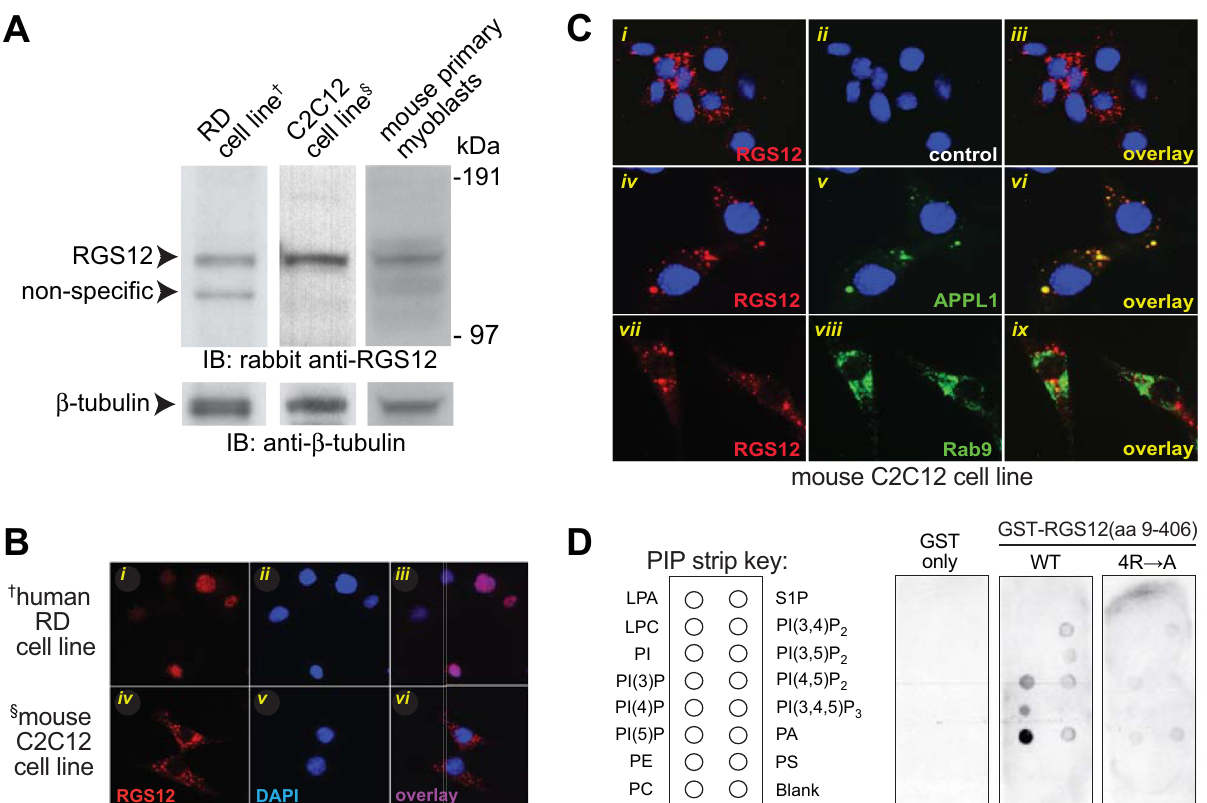
Fig 2. RGS12 expression is observed in cytosolic puncta within the myoblastic C2C12 cell line, but localized in the nucleus in the poorly differentiating human RD cell line. (A) Immunoblotting (IB) of cell lysates from all three cell types indicates RGS12 protein expression, as detected using a rabbit anti-RGS12 polyclonal antibody previously described [7]; β -tubulin protein levels were also examined by immunoblotting in parallel as a loading control. (B) Cultures of the poorly differentiating, human rhabdomysarcoma RD cell line and the more-easily differentiated, mouse C2C12 cell line were separately fixed and stained with DAPI; RGS12 protein was detected by indirect immunofluorescence using UNC60-26.2.1. Panels (i-vi) represent: (i, iv) anti-RGS12 antibody detection with Alexa-fluor-594 secondary antibody; (ii, v) DAPI nuclear stain; and, (iii, vi) overlay of both images. (C) Endogenous RGS12 localizes to early (APPL1-positive) endosomes within C2C12 cells. C2C12 cell line cultures (4 x 10 5 cells/well) were maintained in growth medium (DMEM containing 10% fetal bovine serum [FBS]) for two days. Cells were then fixed in paraformaldehyde, permeabilized, and stained with primary mouse monoclonal antibody UNC60-26.2.1 and secondary Alexa-fluor-594 anti-mouse antibody, alone or in combination with primary anti-APPL1 or -Rab9 rabbit polyclonal antibodies followed by Alexa-fluor-488 secondary anti-rabbit antibody. Overlays in panels (vii-ix) are absent the DAPI nuclear stain ( blue ) to highlight lack of overlap between RGS12 and Rab9 signals. (D) RGS12 N-terminus binds to select phosphatidylinositides in a lipid dot-blot protein overlay assay. A “PIP Strip” nitrocellulose membrane pre-spotted with the indicated phospholipid species was probed with 20 μ g/mL of GST alone, recombinant GST-RGS12 protein (amino-acids 9–406 spanning PDZ and PTB domains; “WT”), or GST-RGS12(aa 9–406) protein with alanine substitutions to four arginines in the PTB domain (Arg-255, -260, -262, and -308; “4R ! A”) previously predicted by electrostatic contouring [61] to be involved in phospholipid binding. After extensive washing, the binding of protein to phospholipid spots was detected by chemiluminescence using anti-GST mouse monoclonal antibody and anti-mouse-horseradish peroxidase conjugated secondary antibody. Lipid abbreviations: LPA, lysophosphatidic acid; LPC, lysophosphocholine; PI, phosphatidylinositol; PE, phosphatidylethanolamine; PC, phosphatidylcholine; S1P, sphingosine-1-phosphate; PA, phosphatidic acid; PS, phosphatidylserine.